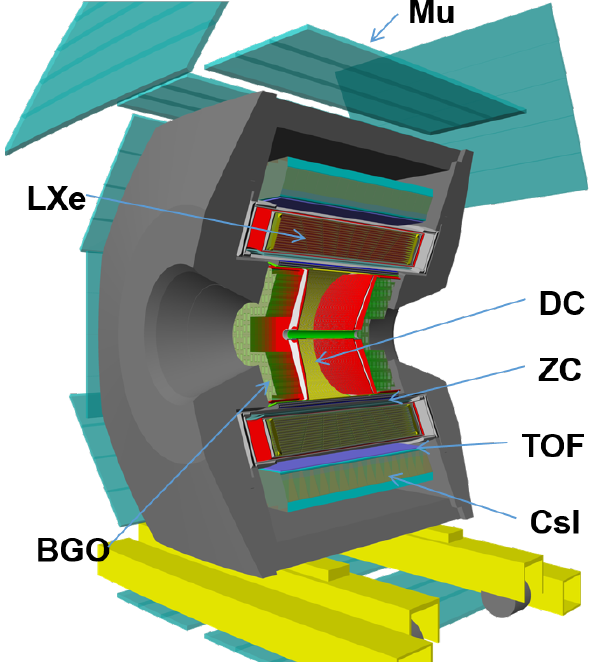
Figure 1: The CMD-3 detector. DC – drift chamber, ZC – multiwire proportional chamber used for the trigger and z-coorsinate measurement, LXe – liquid Xe calorime- ter, CsI – calorimeter based on scintillation CsI crystals, TOF– time-of-flight system, BGO – end cap calorimeter based on BGO scintillation crystals.